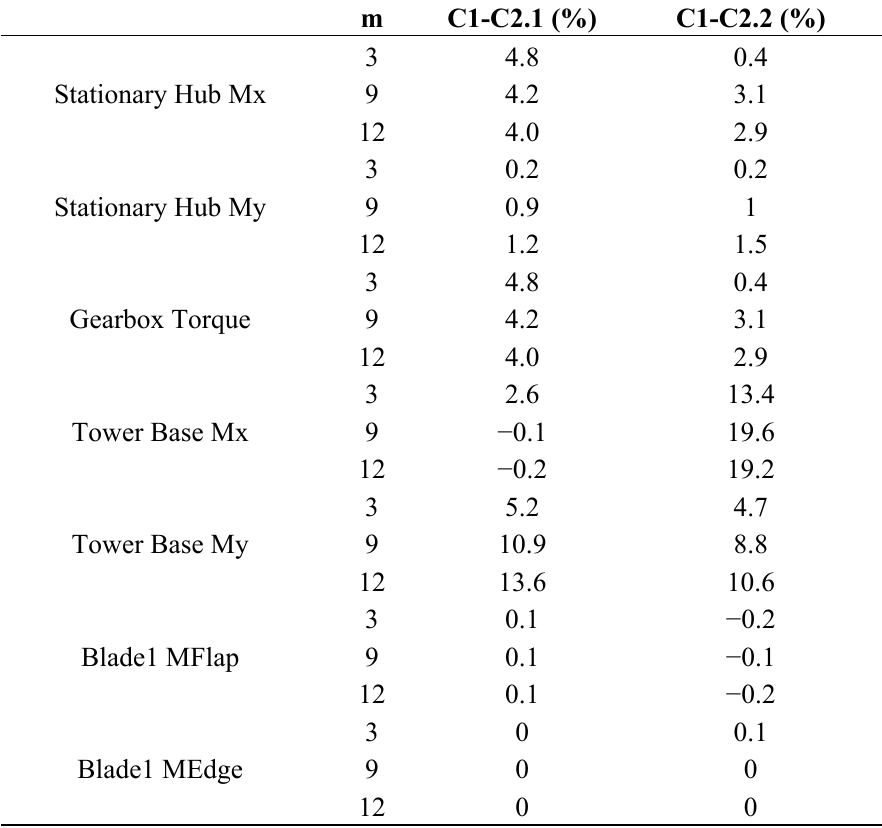
Table 4. Comparison of the load equivalent